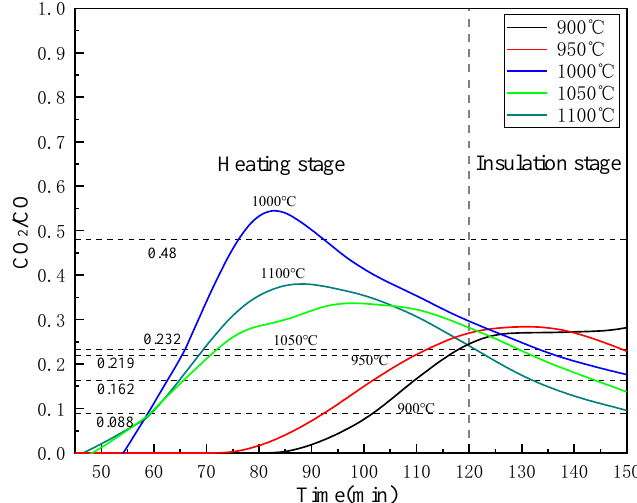
Figure 13. Effects of temperatures on CO 2 /CO in the off-gas.